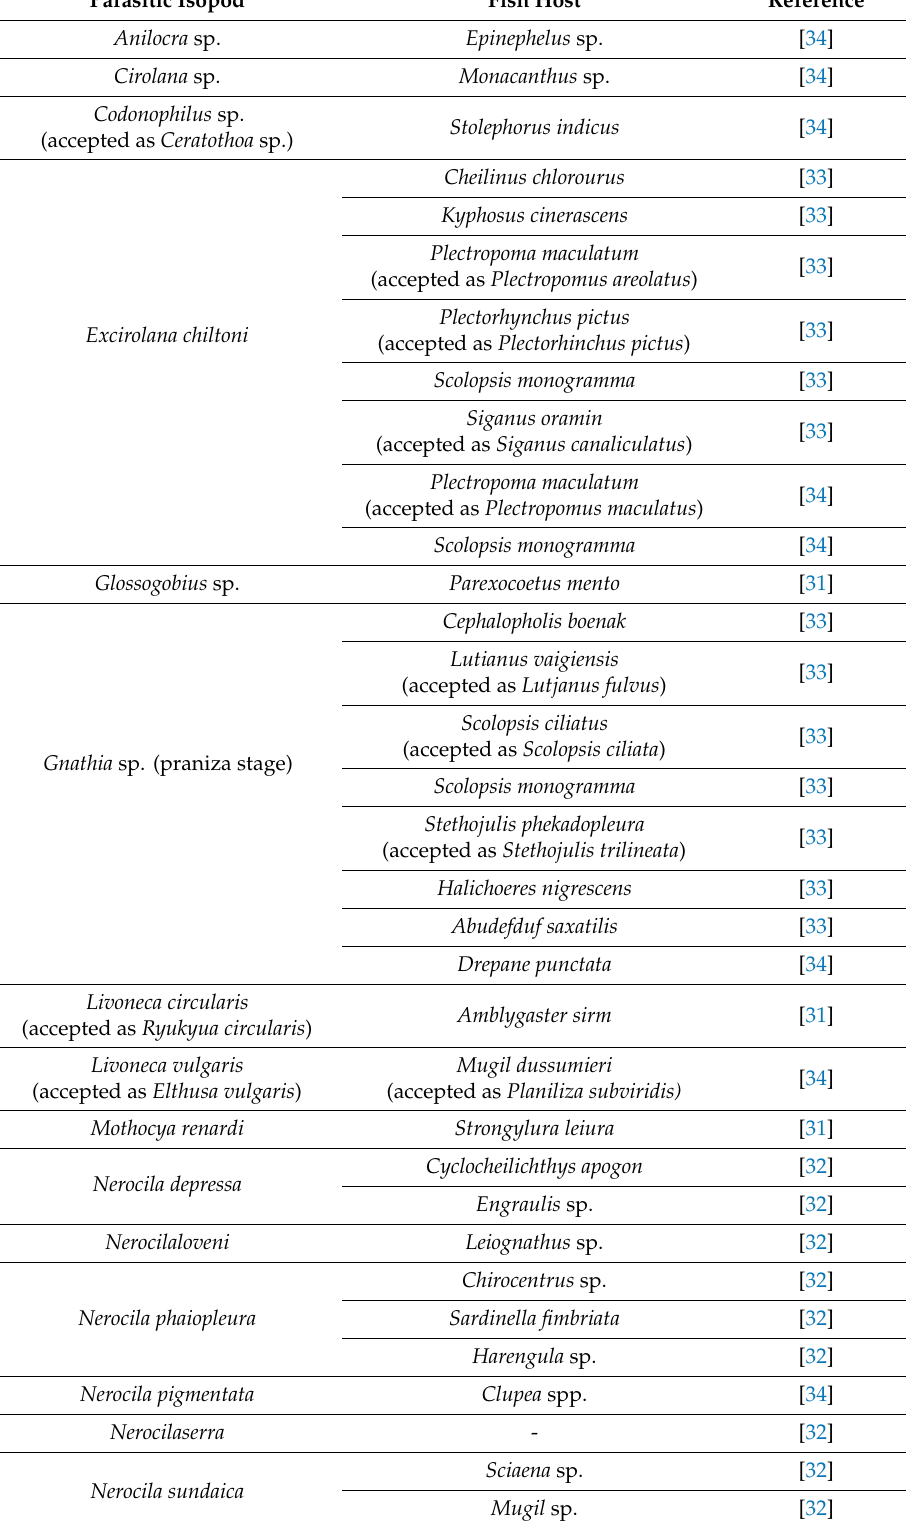
Table 1. Parasitic isopods with their host recorded in Thailand from the literature